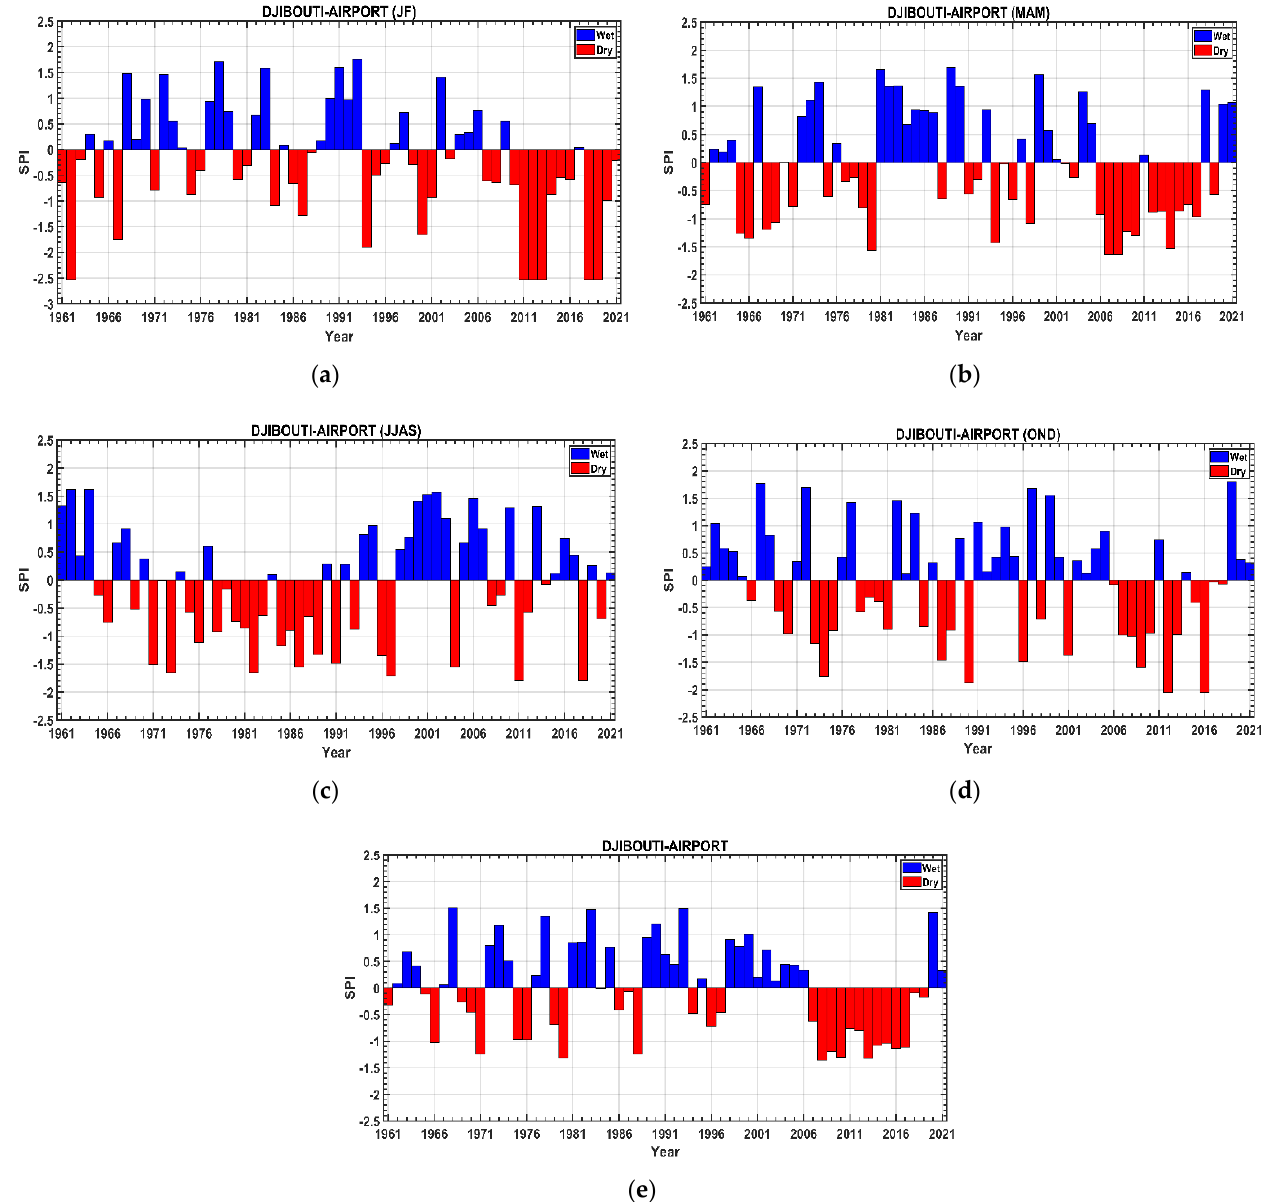
Figure 8. Seasonal (( a ) JF, ( b ) MAM, ( c ) JJAS, and ( d ) OND) and ( e ) annual variability in the SPI over the period 1961–2021 at the Djibouti Airport station.